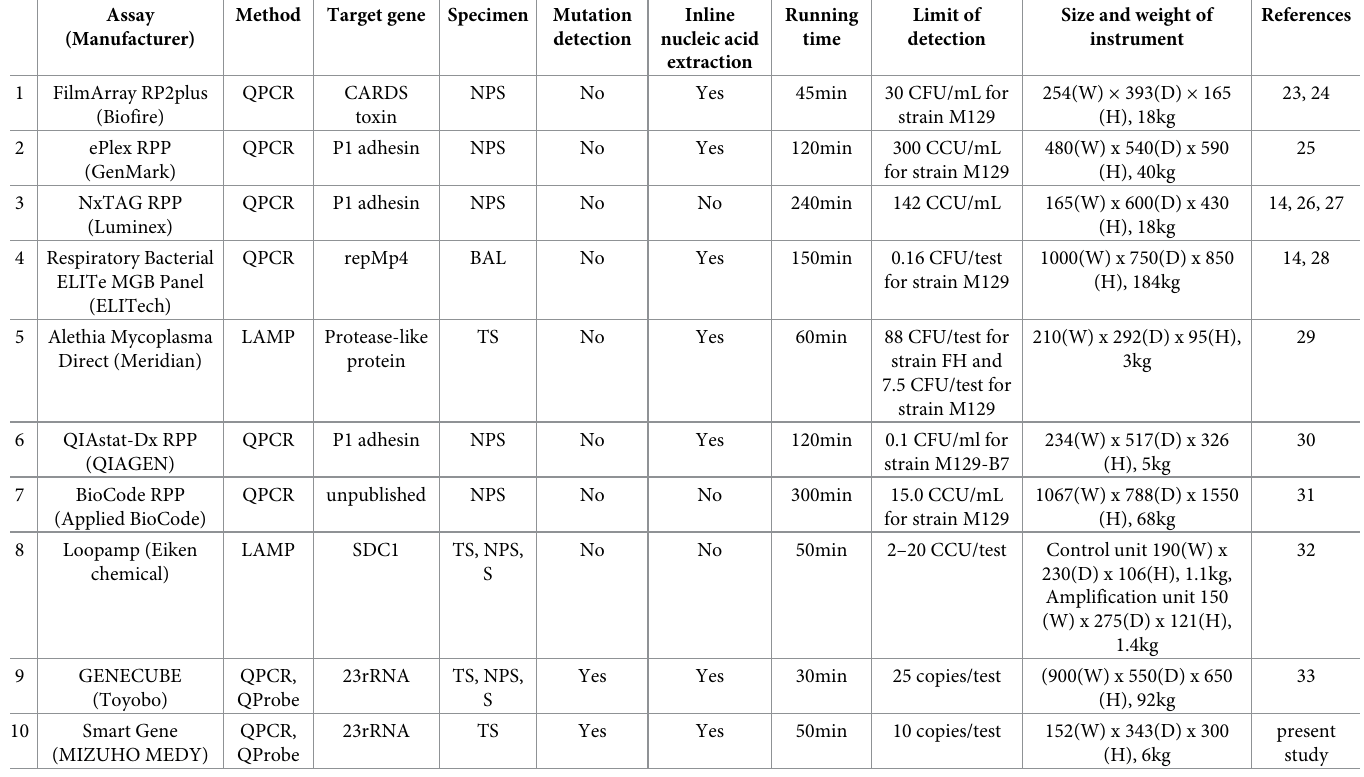
Table 3. Comparison of commercial molecularly based assays for detection of M . pneumoniae